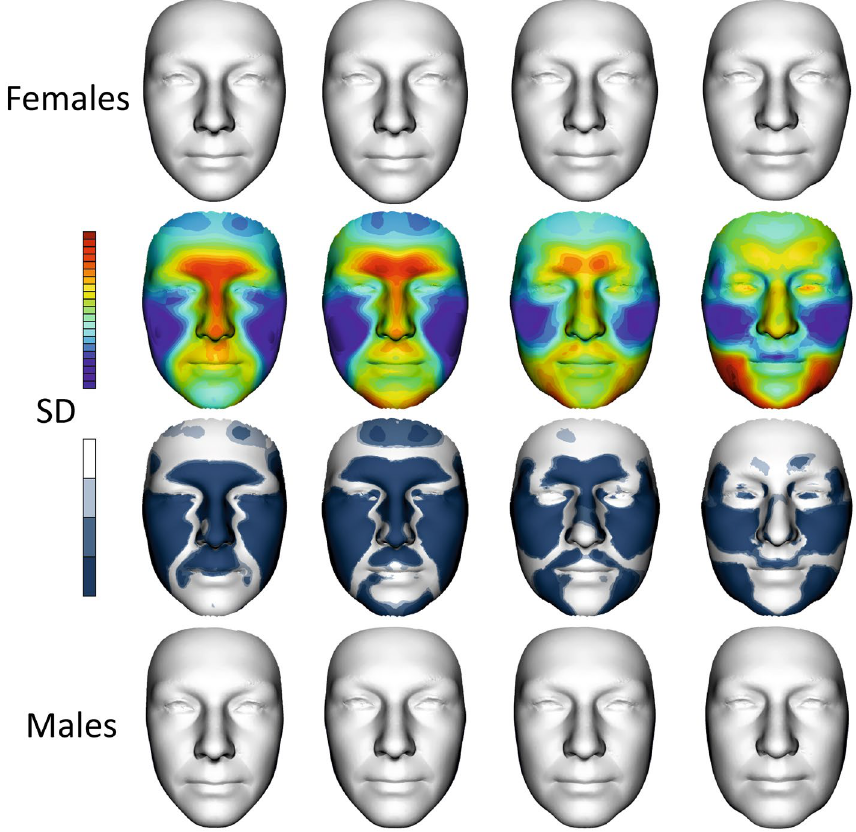
Figure 5. Development of sexual dimorphism of facial shape. The first row shows female average faces in all age categories, i.e., 0, I, II and III. The second row is a superimposition of the mean facial shapes of males and females in all age categories. The colour maps show the relative reciprocal locally inward/outward positions of the mean male and female facial shapes. Red denotes that a particular area of the male face was located in front of the female face after superimposition, while blue indicates the converse condition. The third row shows shell distance significance of sexual dimorphic maps in each age category. The last row shows average male faces in all age categories. (SD—shell